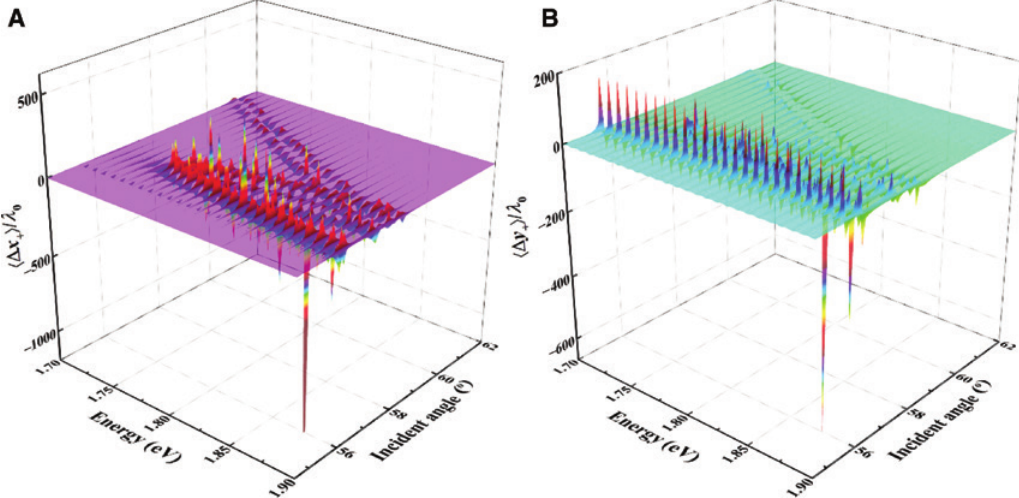
⟩ and ⟨ Δ y ⟩. They have a similar change tendency with the minimum + +